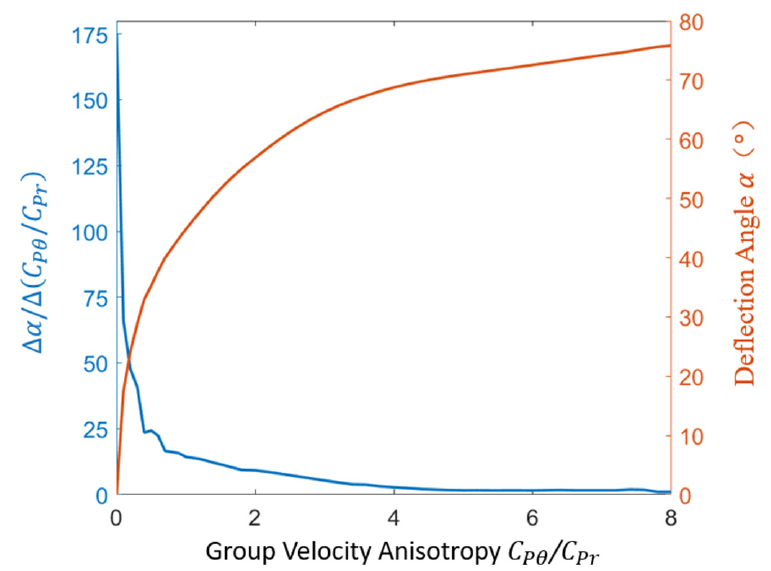
Figure 13. Relationship between group velocity anisotropy and the deflection angle of the energy- flow vector.